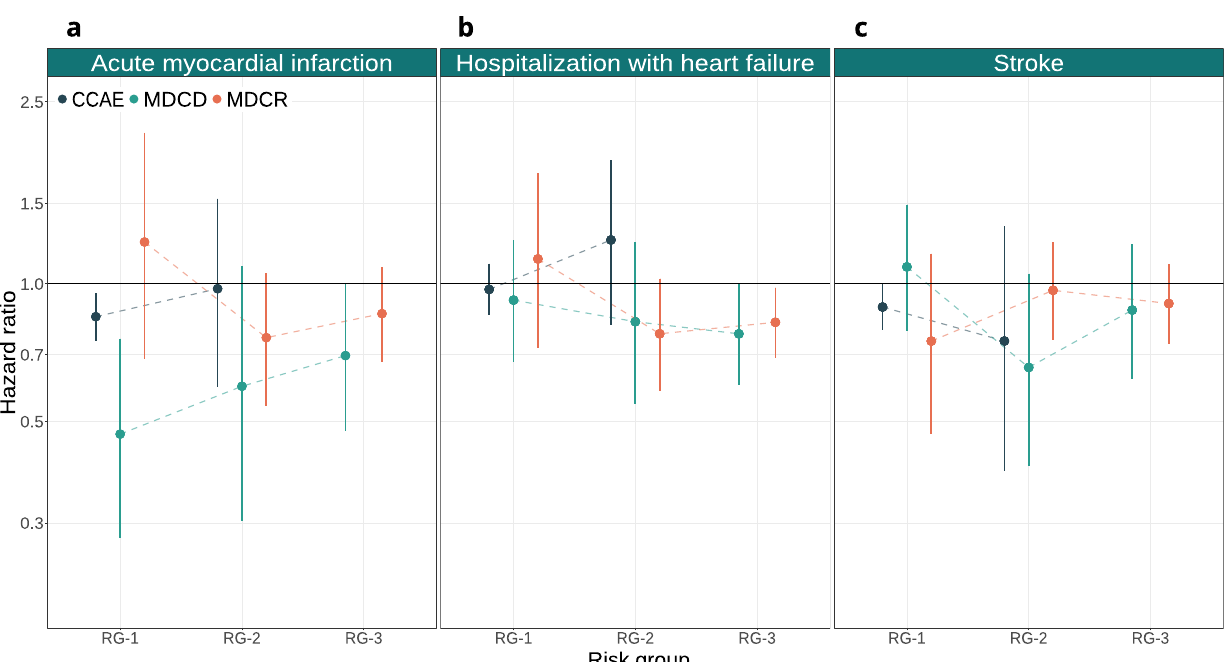
Fig. 5 Relative treatment effects for main outcomes. Treatment effect heterogeneity for the main outcomes on the relative scale (hazard ratios) of thiazide or thiazide-like diuretics compared to ACE inhibitors within strata of predicted acute MI risk. In a we present treatment effects on the relative scale for acute MI within groups of predicted acute MI risk across all three databases. In b we present treatment effects on the relative scale for hospitalization with heart failure within groups of predicted acute MI risk across all three databases. In c we present treatment effects on the relative scale for stroke (both ischemic and hemorrhagic) within groups of predicted acute MI risk across all three databases. RG-1 represents the group of patients with acute MI risk below 1%; RG-2 represents the group of patients with acute MI risk between 1% and 1.5%; RG-3 represents the group of patients with acute MI risk larger than 1.5%. Hazard ratios estimated in CCAE, MDCD, and MDCR are represented by blue, green, and orange circles, respectively. The bars represent 95% con fi dence intervals. Values below 1 favor thiazide or thiazide-like diuretics, while values above 1 favor ACE